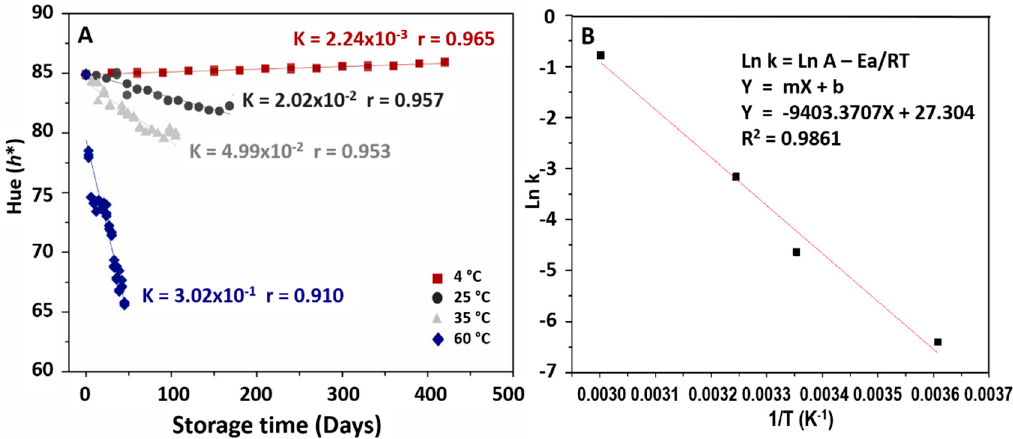
Figure 2. Change of hue coordinate as a function of storage time in accelerated shelf-life test in lemon residues flours obtained by thermal process at 50 °C, and fit to linear regression.